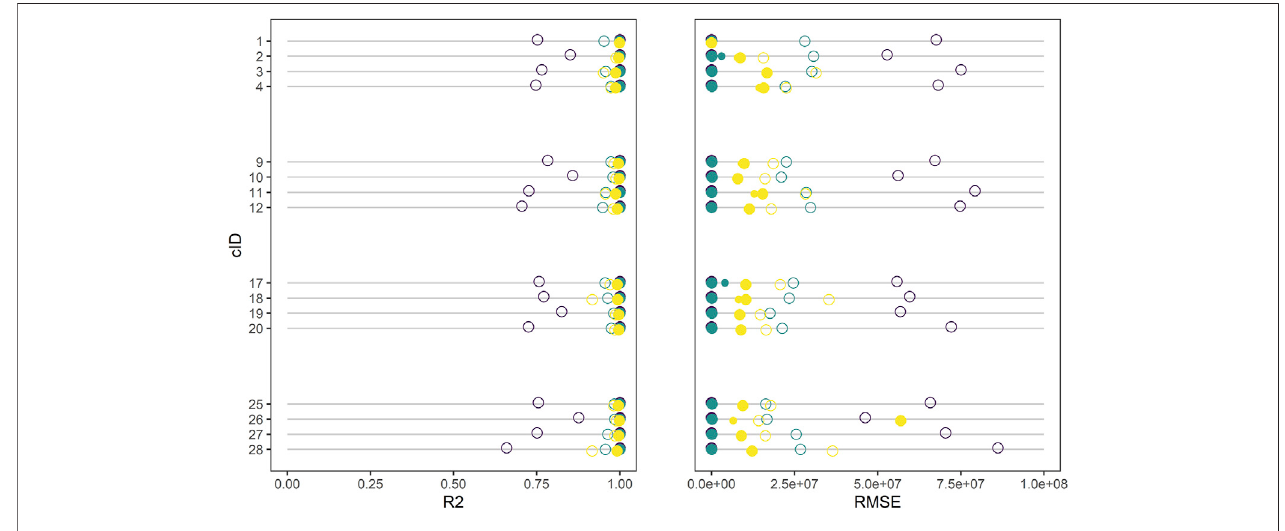
FIGURE 5 | Validation metrics of the surrogate models.